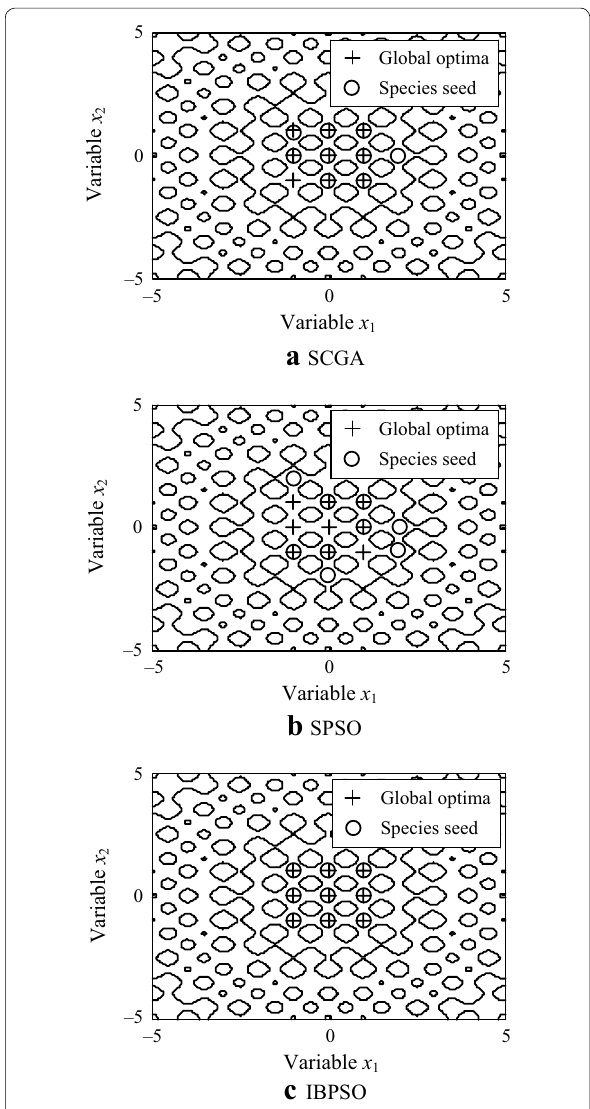
Figure 3 Optimizing results of three algorithms